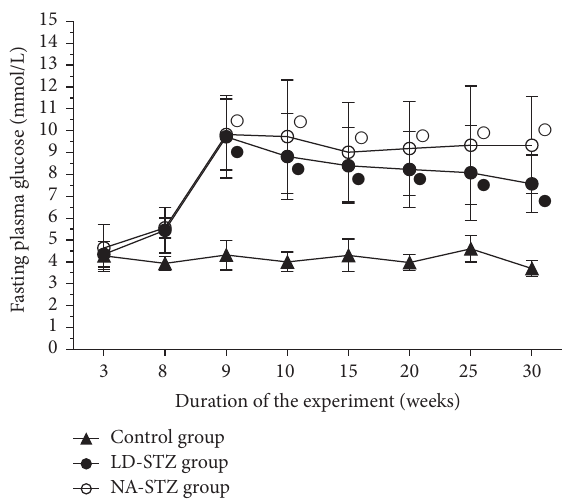
Figure 5: Fasting plasma glucose levels in the experimental groups. Overnight fasting blood glucose was measured for the first time 3 weeks after unilateral nephrectomy; the second point of measurement assessed the effects of five-week high-fat diet with beef tallow. OGTT was performed 1 week after STZ administration (at week 9). 2 weeks after induction of diabetes fasting blood glucose levels were measured every 5 weeks until the end of the experiment at week 30. Mean values and standard deviations are shown. I – 𝑃 < 0.05 in NA-STZ diabetic group versus control nondiabetic group. e - 𝑃 < 0.05 in LD-STZ diabetic group versus control nondiabetic group. Nonsignificant difference between NA-STZ and LD-STZ groups is not shown.